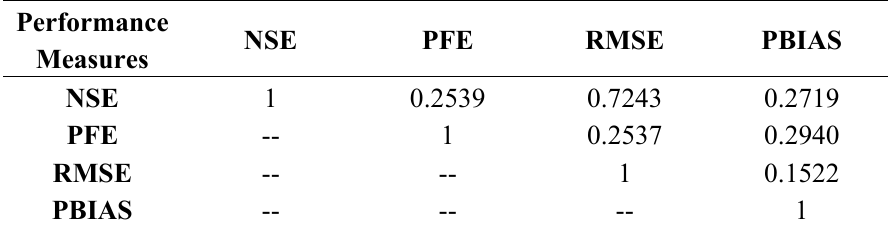
Table 4. Correlations among all rankings to four performance measures.